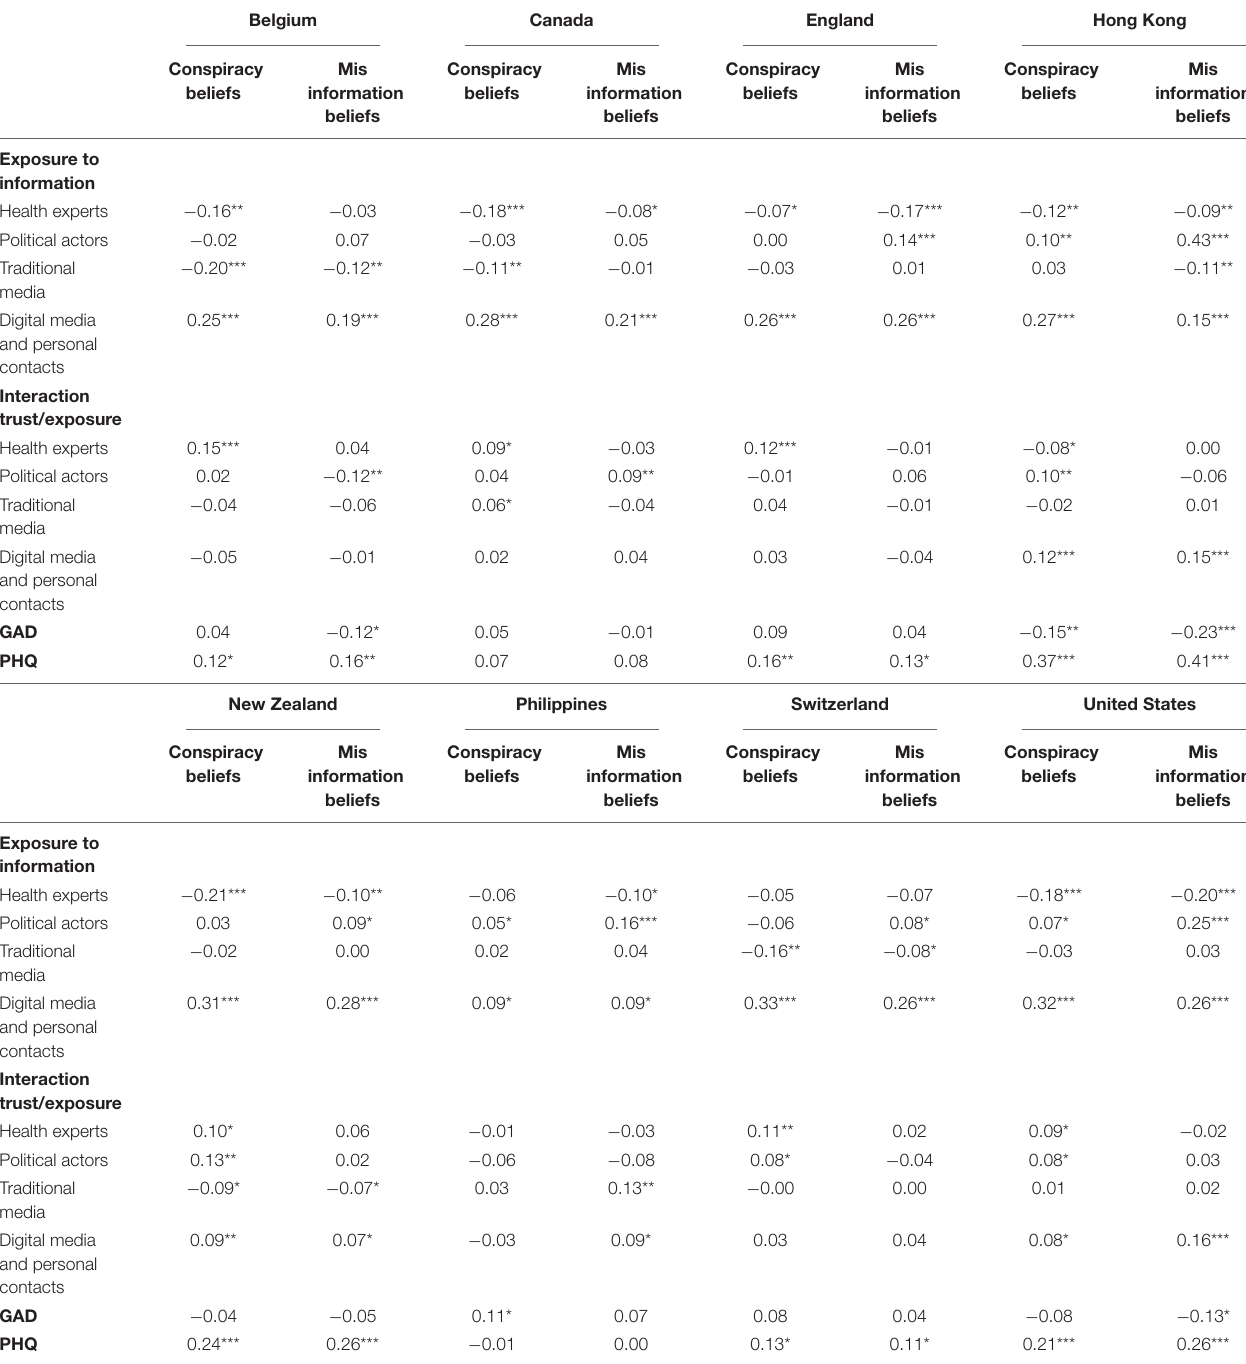
TABLE 5 | Direct standardized effects of predictors on conspiracy beliefs and misinformation beliefs per country.